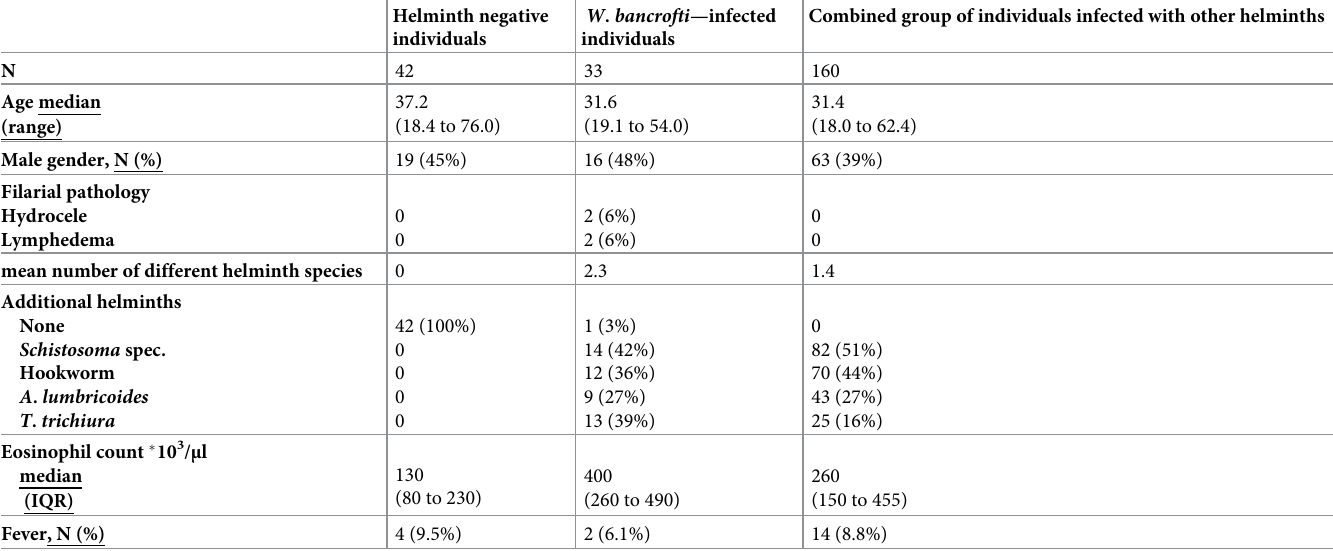
Table 1. Participant characteristics by helminth status. The group of W . bancrofti infected individuals was compared to helminth–free individuals and a group of par- ticipant infected with other helminth species. For each group the median age, gender distribution, pathology, the mean number of different helminth species, and the per- centage of each type of helminth in the respective group, median eosinophil count and percentage of individuals with fever is